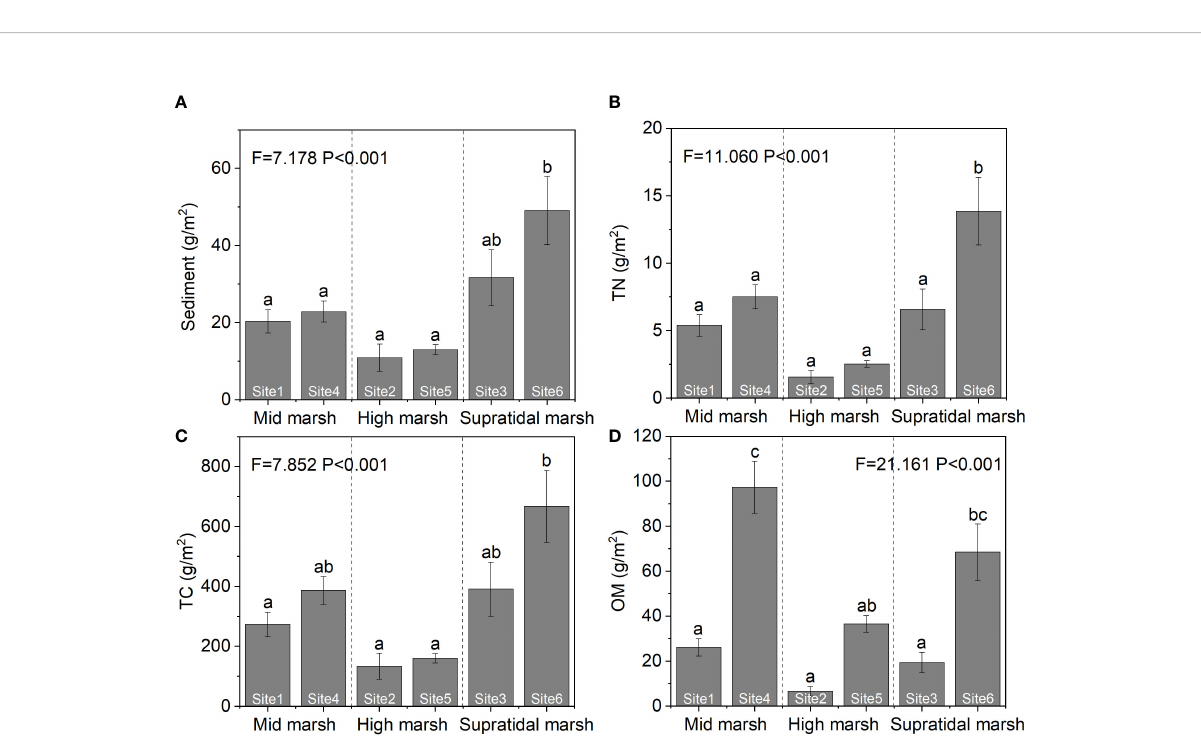
FIGURE 9 Contributions of the ecosystem engineers, (H) tientsinensis, to sediment (A) , TN (B) , TC (C) , and OM (D) excavation among the three marsh zones in the Yellow River Delta. Data are shown as means ± SE. Letters indicate signi fi cant differences with a Tukey